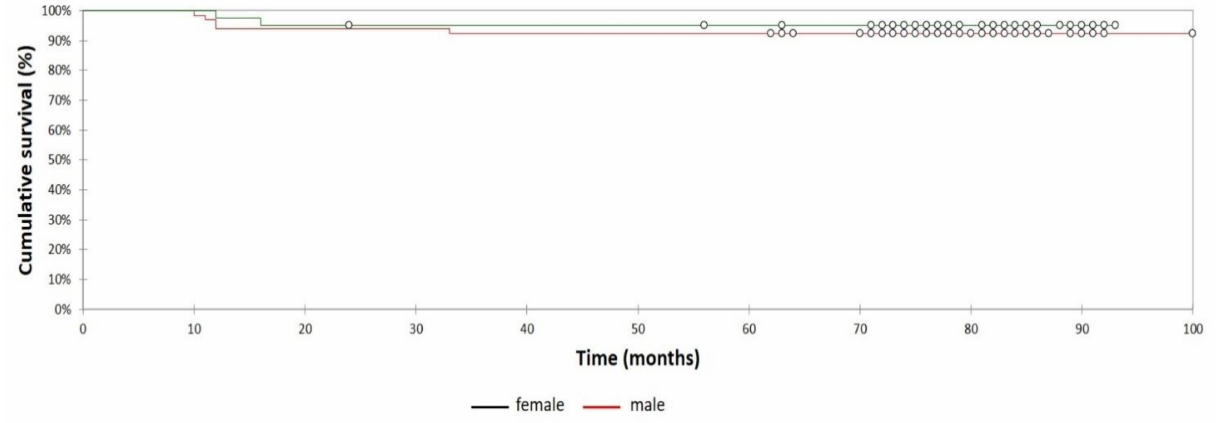
Figure 3. Kaplan-Meier survivorship curve and 95% confidence intervals with revision for any reason as the endpoint according to gender. 6.3-year survival was estimated at 95% (95% CI, 88–99%; 63 hips at risk) for male patients and 100% ([95% CI, 86–99%; 39 hips at risk) for female patients. (Log rank test, p =0.58).